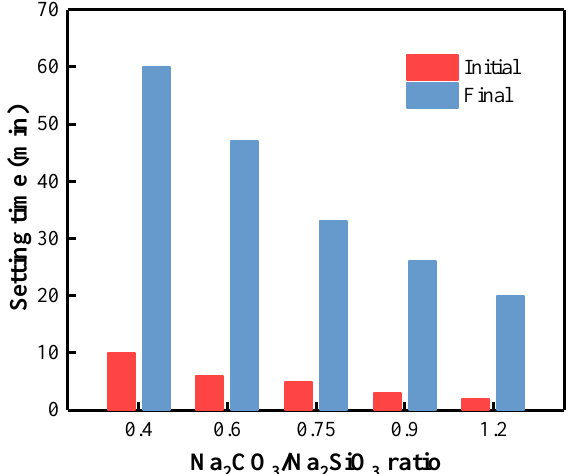
Figure 9. Initial and final setting times of BFA-based AAM pastes with different C/S ratios.